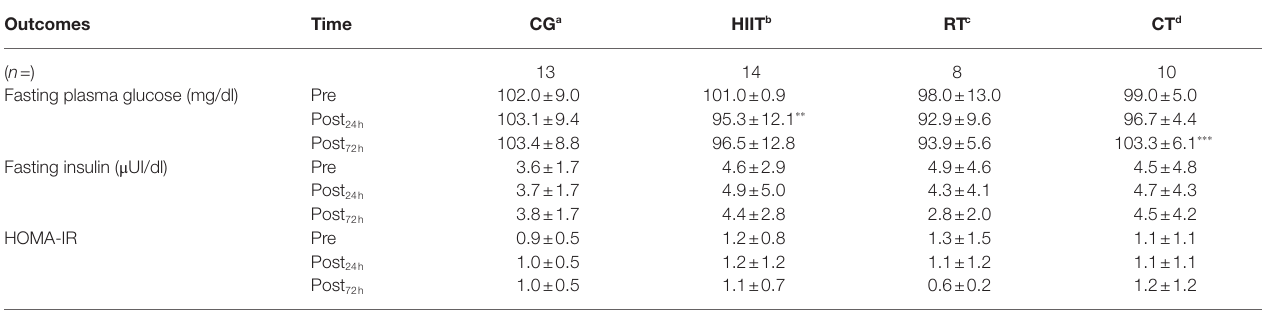
** Significant differences from pre- to post-24 h by two-way ANOVA (group × times) at p < 0.001. *** Significant differences from post-24 h to post-72 h by two-way ANOVA (Group × Time) at p < 0.001. Data are shown as mean and ± SD. Groups are described as: Control group (CG), High-intensity interval (HIIT), Resistance training (RT), and Concurrent training (CT). Bold values denote significant pre-post changes at p < 0.05 by repeated evaluations × group. Univariant analysis was applied to test baseline differences among groups denoted (a, b, c, or d). value of p significant differences was remarked in